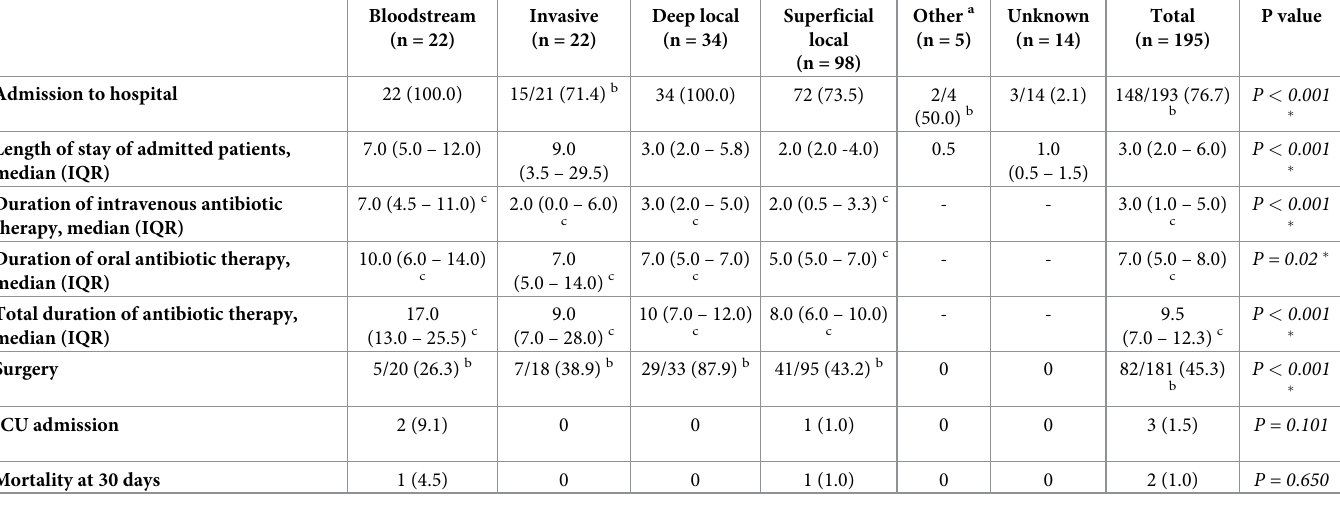
Table 3. Management and clinical outcomes of patients with Pasteurella spp.